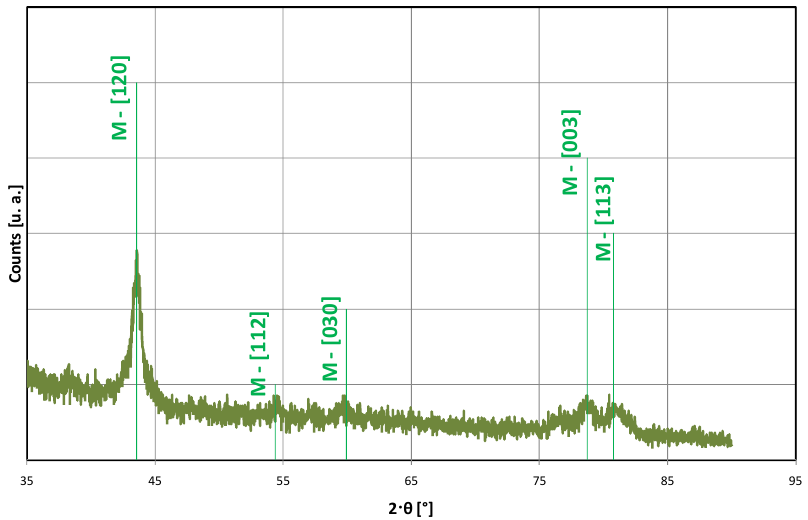
Figure 10: X-Ray spectra obtained from monotonic loading up to  g